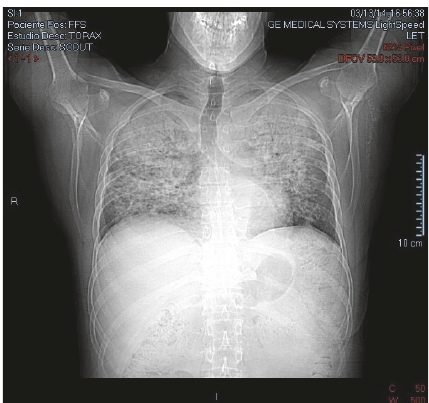
Figure 1: Pulmonary CT-scan with evidence of atypical bilateral pneumonia: pulmonary parenchyma with multiple areas of intersti- tial infiltrates (patchy infiltrates) involving apical and medial areas of both pulmonary